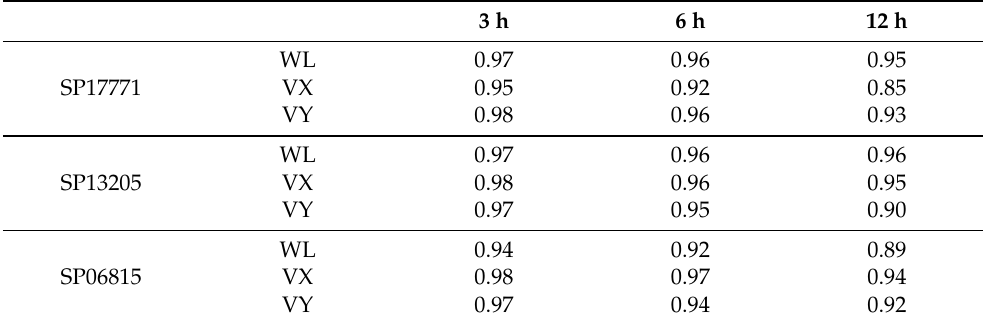
Table 6. Summary of R squared ( R 2 ) between neural network forecast and ADCIRC simulation for water level (WL), velocity in the x direction (VX), and velocity in the y direction (VY) for three save points for three forecast lead times (i.e., 3 h, 6 h, and 12 h) using 50 test storms. 3 h 6 h